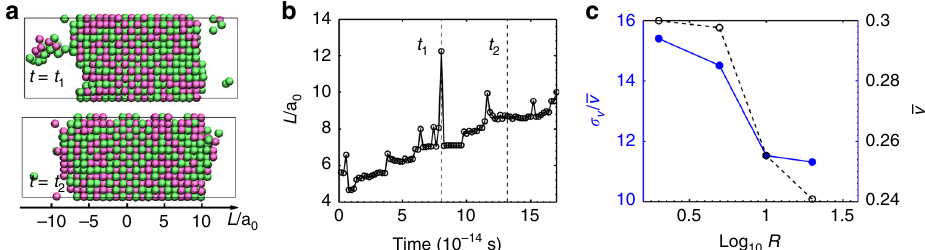
Fig. 4 MD simulations of isothermal crystallization of binary Lennard – Jones glasses. a Two snapshots of a Lennard – Jones binary glass sample during an isothermal simulation at T = 0.1 at two times t 1 (top) and t 2 (bottom). t 1 and t 2 are de fi ned in b . The snapshots only show crystalline atoms for clarity. The full con fi guration (crystalline and amorphous atoms) are in Supplementary Fig. 3. The pink and green colors represent the A and B atom types, respectively. b Location of the left boundary, L , between the crystalline region and the remaining glass region as a function of time t for simulations in ( c ). The boundary location is normalized by the size of the large atom ( σ A ). The boundary location increases with time, indicating crystal growth. Occasionally, the boundary location exhibits large fl uctuations and sudden jumps, such as the one at t 1 . The large peak at t 1 is due to a cluster that is connected to the crystalline = (cid:1) υ , and (right) the mean growth rate, (cid:1) υ ; as a section in the middle. c (Left) Standard deviation of the growth rate normalized by the mean growth rate, σ v function of the cooling rate, R , used to generate the glasses. Sixteen independent simulation samples were run to obtain the standard deviation and mean of the growth rate. Glasses prepared at slower cooling rates exhibit larger standard deviations in the growth rate and higher average growth